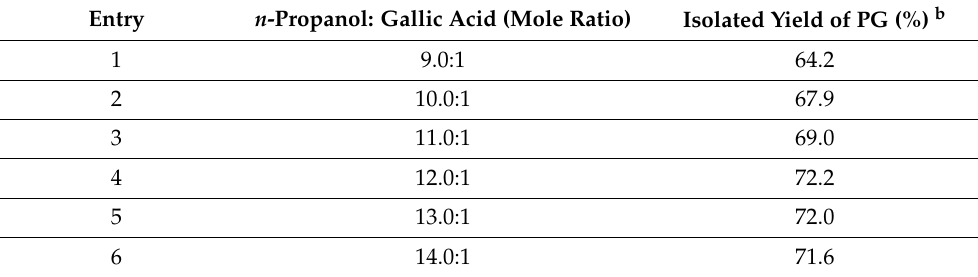
Table 4. Effect of mole ratio of reactants on the yield of propyl gallate a .